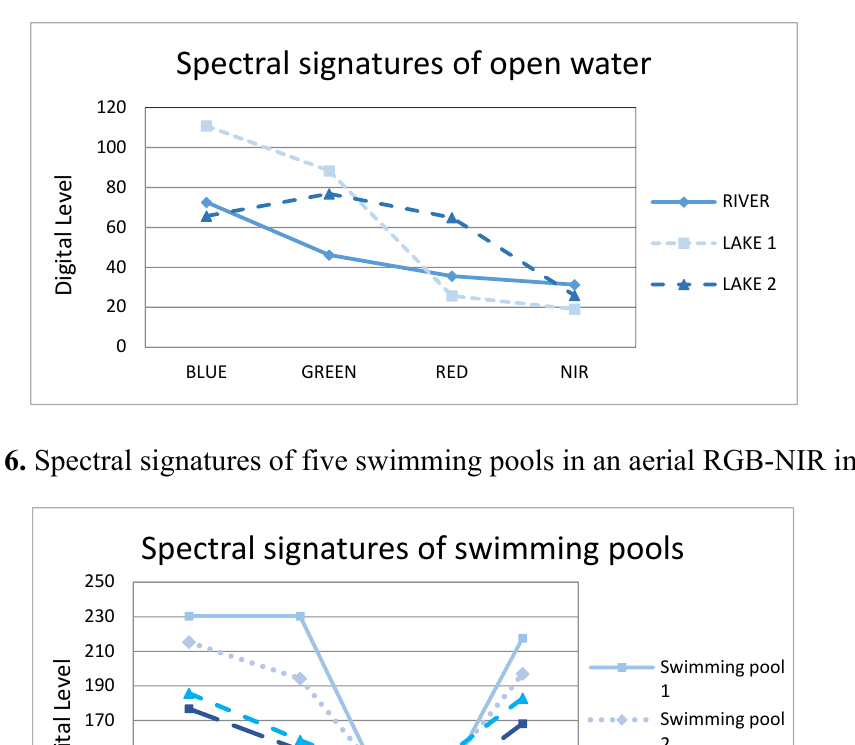
Figure 5. Spectral signatures of a river and two lakes in an aerial RGB-NIR image.